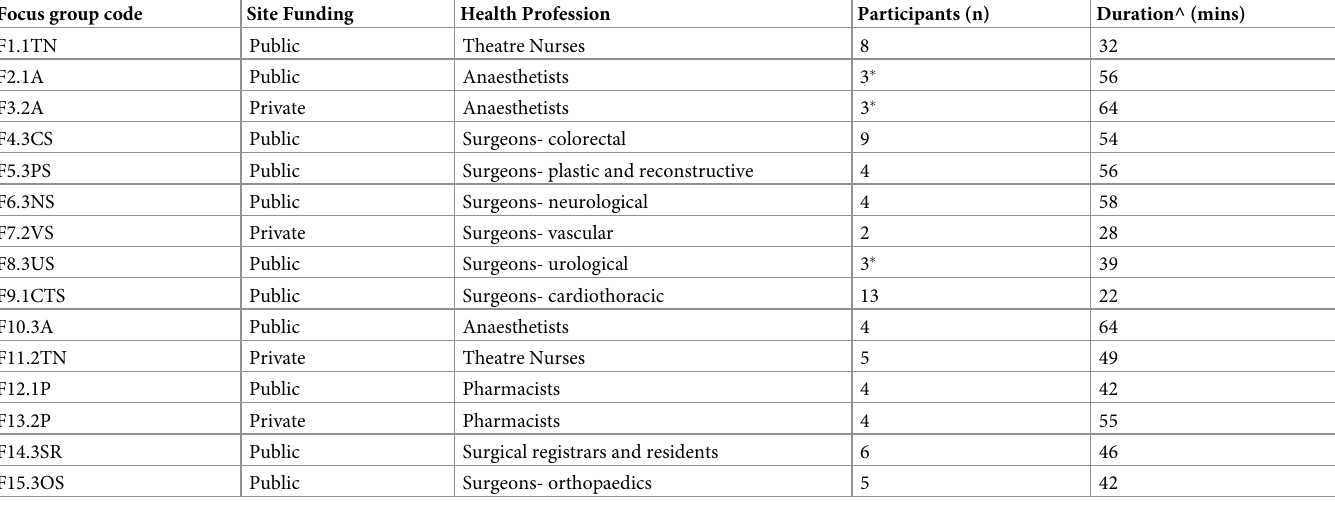
Table 1. Focus group participant